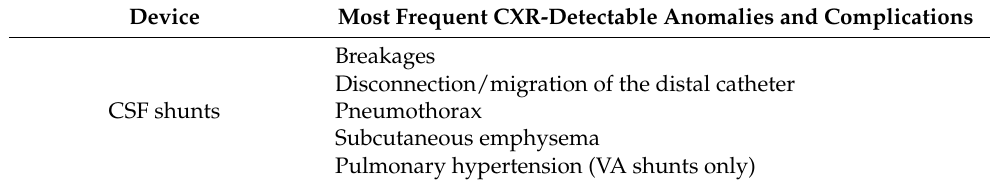
Table 7. CSF shunts’ most frequent CXR-detectable anomalies and